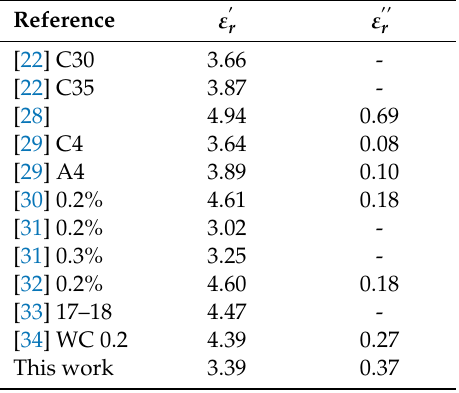
Figure 12. Average values of the real and imaginary parts of the concrete material relative permittivity obtained in this work and the real relative permittivity of two different samples measured in [22]. obtained in this work and the real relative permittivity of two di ff erent samples measured in [22]. Table 3. Concrete material relative permittivity values available in the literature.